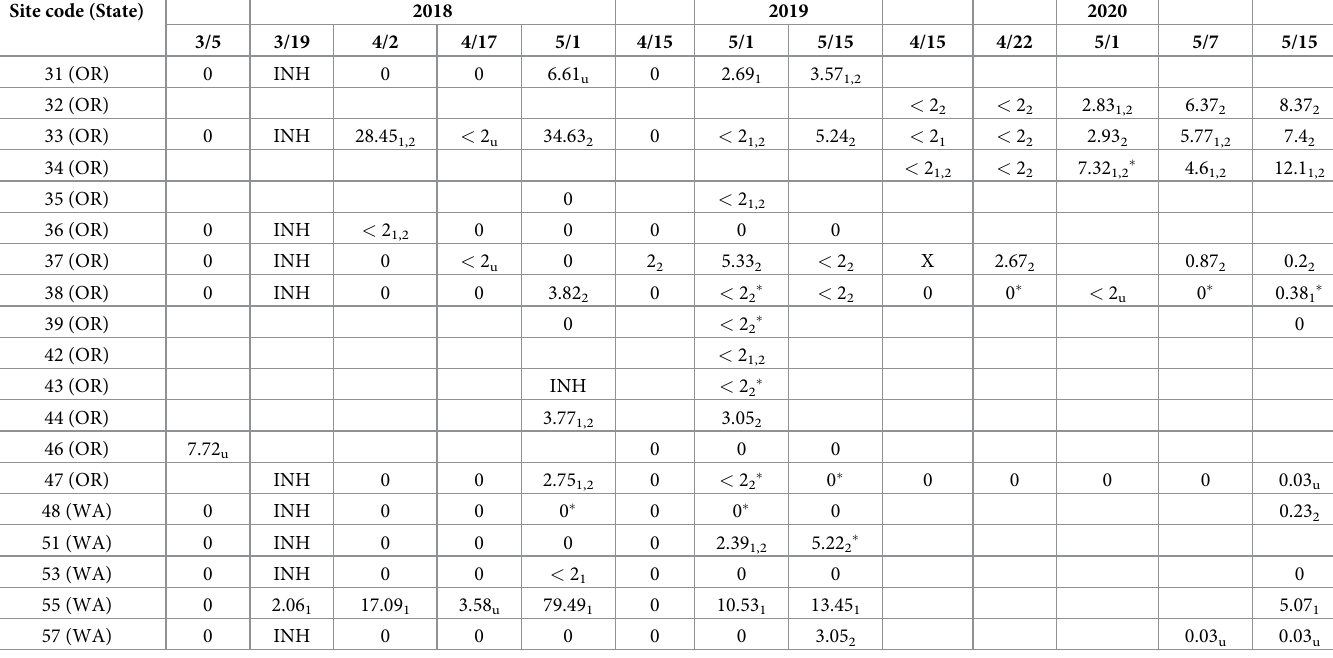
Table 4. Sample site code, Ceratonova shasta density (spores/ L), and genotypes (subscript 1 = I, 2 = II, u = unknown) measured at tributary sites in the lower Columbia River Basin, 2018–2020. INH indicates the qPCR reaction was inhibited and spores could not be quantified or genotyped. The table excludes sample sites where C . shasta was never detected. Blank cells indicate the site was not sampled during a particular sample